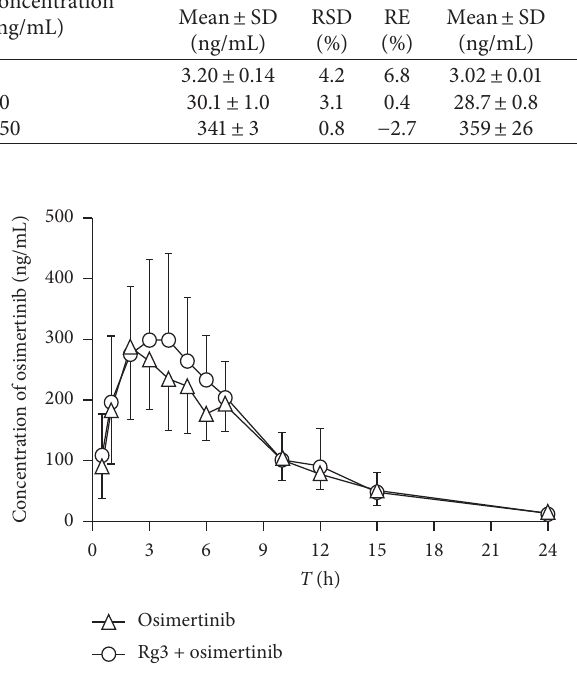
Table 5: Stability of osimertinib in rat plasma under various storage conditions ( n � 6). Spiked concentration (ng/mL)